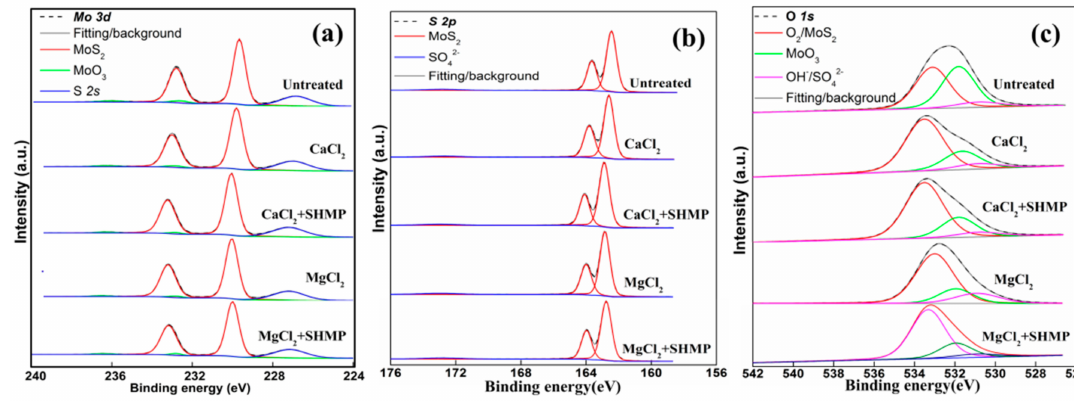
Figure 11. XPS spectra of: ( a ) Mo 3 d ; ( b ) S 2 p ; and ( c ) O 1 s .